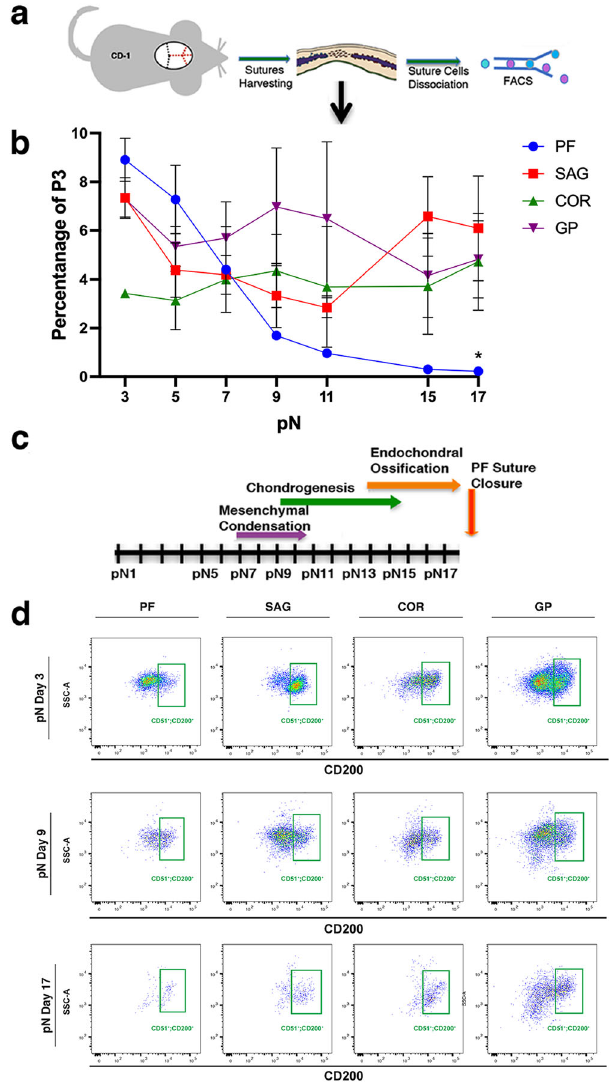
Fig. 1 Temporal FACS pro fi ling of CD51 + ;CD200 + cells in patent and fusing cranial sutures. a Outline of calvarial suture harvesting and processing. b Time-course pro fi ling of skeletal stem/progenitor cells isolated in vivo by fl ow cytometric analysis from freshly harvested posterior frontal (PF), sagittal (SAG), and coronal (COR) sutures. Tibial growth plate (GP) was used as reference. Values are given as a percentage of the P3 population, representing viable (propidium iodide-), non-hematopoietic (CD45 − ) cells isolated from the sutures. The fusing PF suture shows a dramatic decrease in the percentage of skeletal stem/progenitor cells between day pN7 and pN9, corresponding to the initiation of PF suture closure 10 . Conversely, the patent SAG and COR sutures and GP maintain a sustained percentage of these cells over time. Data are represented as means ± SEM; PF vs SAG P = 0.002, PF vs COR P = 0.0147, PF vs GP P = 0.0179, * P ≤ 0.05 unpaired, two-tailed student t -test were performed. n = 60 animals/timepoint, experiments were repeated 6 independent times for pN3, 4 for pN17 and 2 independent times for pN5, 7, 9, 11, and 15. c Diagram illustrating the timing of the endochondral differentiation through which the PF suture closes 10 . d Representative FACS plots of skeletal stem/progenitor (CD51 + ;CD200 + ) cells isolated in vivo from the PF, SAG, and COR sutures and GP at pN3, pN9, and pN17. CD51 + ;CD200 + cells decrease as a function of time in the physiologically fusing PF suture. Refer to Supplementary Fig. 1 for complete FACS gating and isolation strategy. Source data are provided as a Source data fi